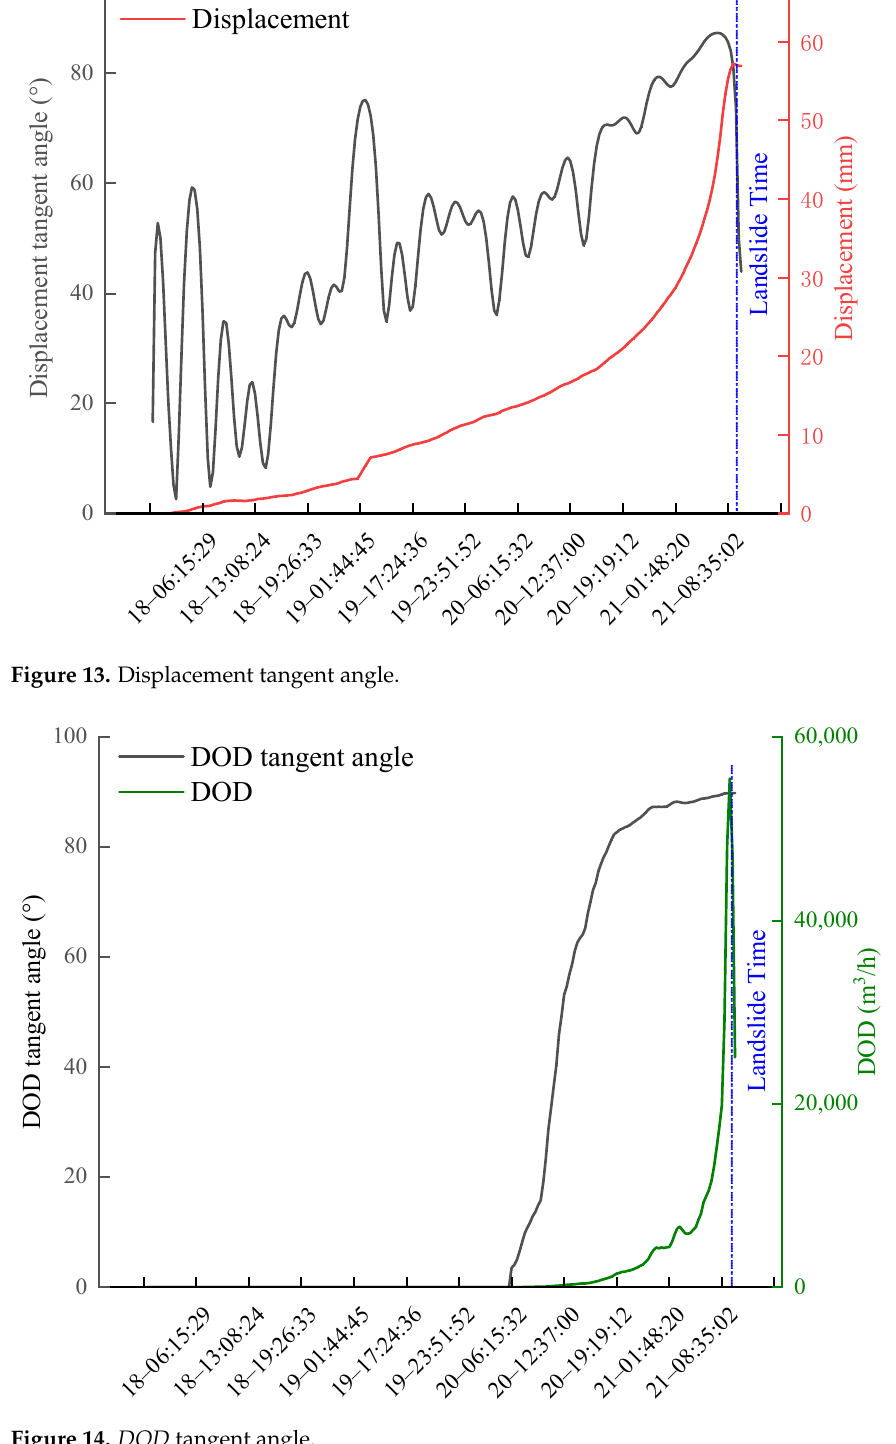
Figure 14. DOD tangent angle. Table 1. Comprehensive early warning criterion at an accelerated stage.